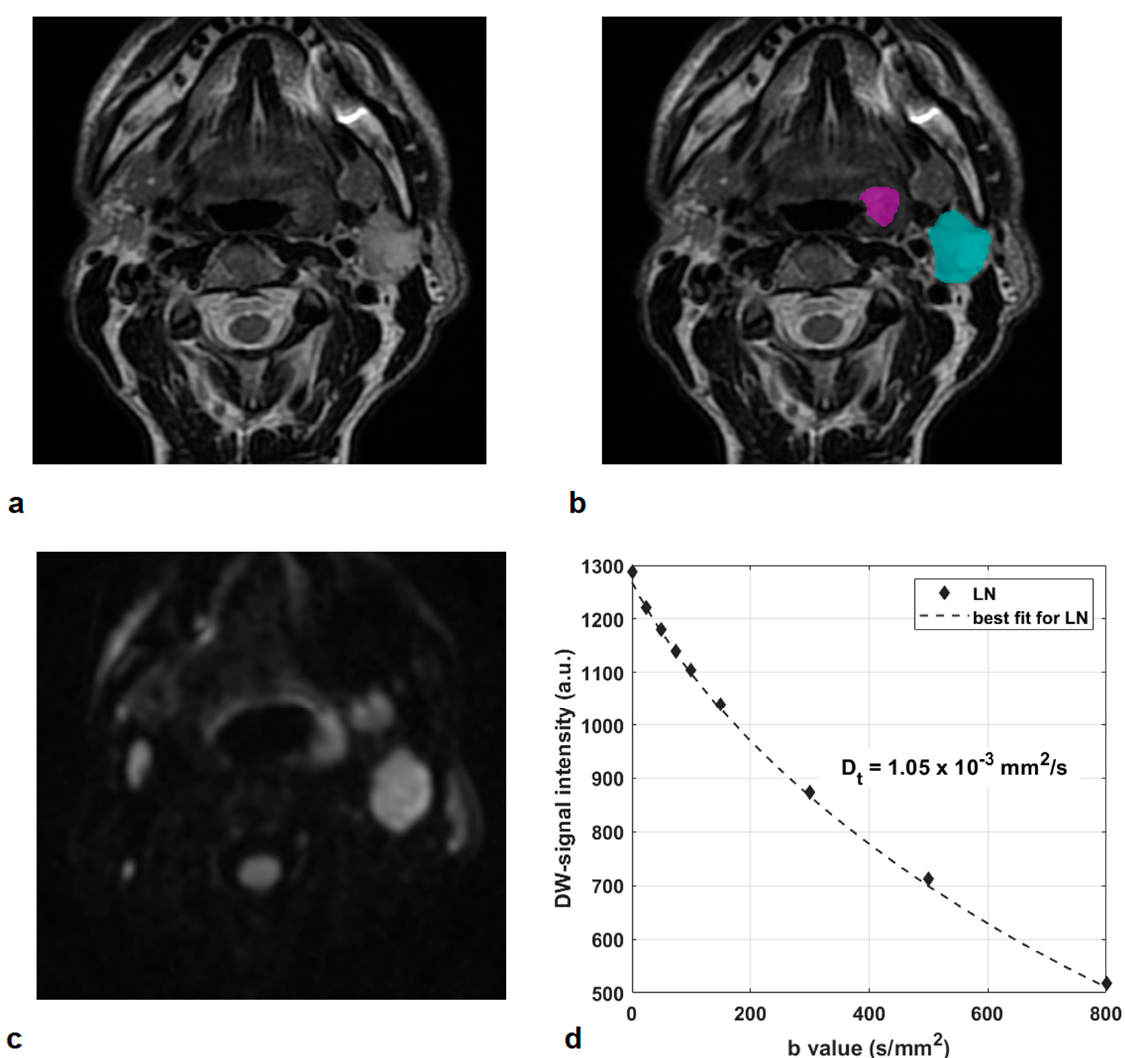
Figure 2. HPV-positive oropharyngeal squamous cell carcinoma of the tonsil in a 71-year-old man, non-smoker, and non-alcoholic (Patient 3): T2-w images ( a , b ) show the primary tumor (contour in magenta) and a large lymph node (contour in cyan). The corresponding DWI at b = 800 s/mm 2 ( c ) and DW-signal intensity curve at increasing b values in the LN ( d ). A restricted water molecule mobility was observed in the LN, with ADC and D t values of 1.17 and 1.05 × 10 − 3 mm 2 /s, respectively.